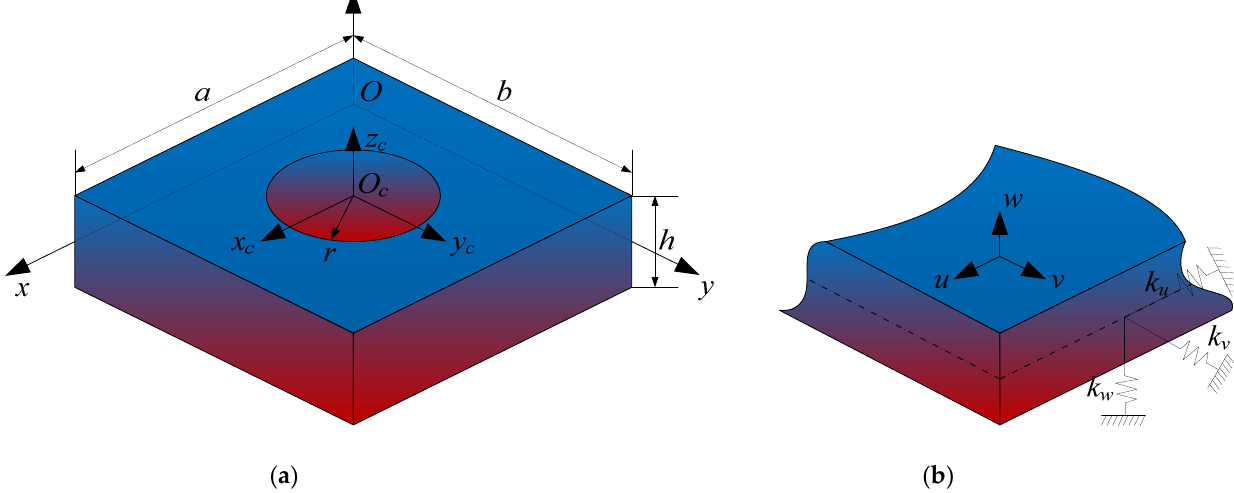
Figure 1. Model of a three-dimensional FGMs rectangular plate with a circular cutout: (a) The geometry and coordinates; (b) The boundary restraining springs.